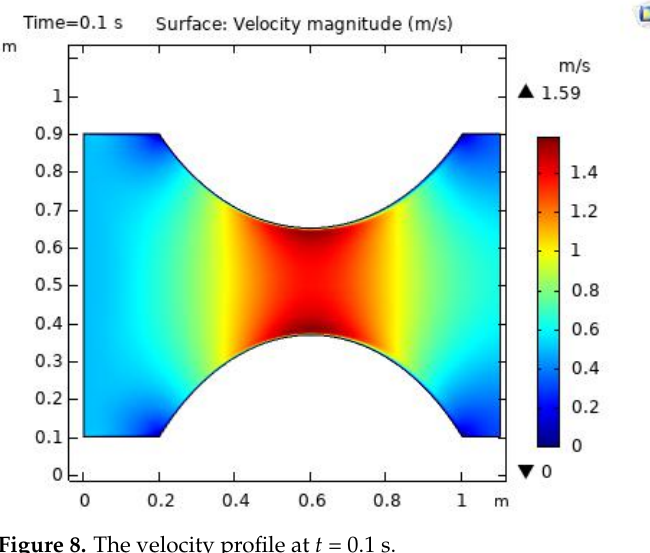
Figure 8. The velocity profile at t = 0.1 s.